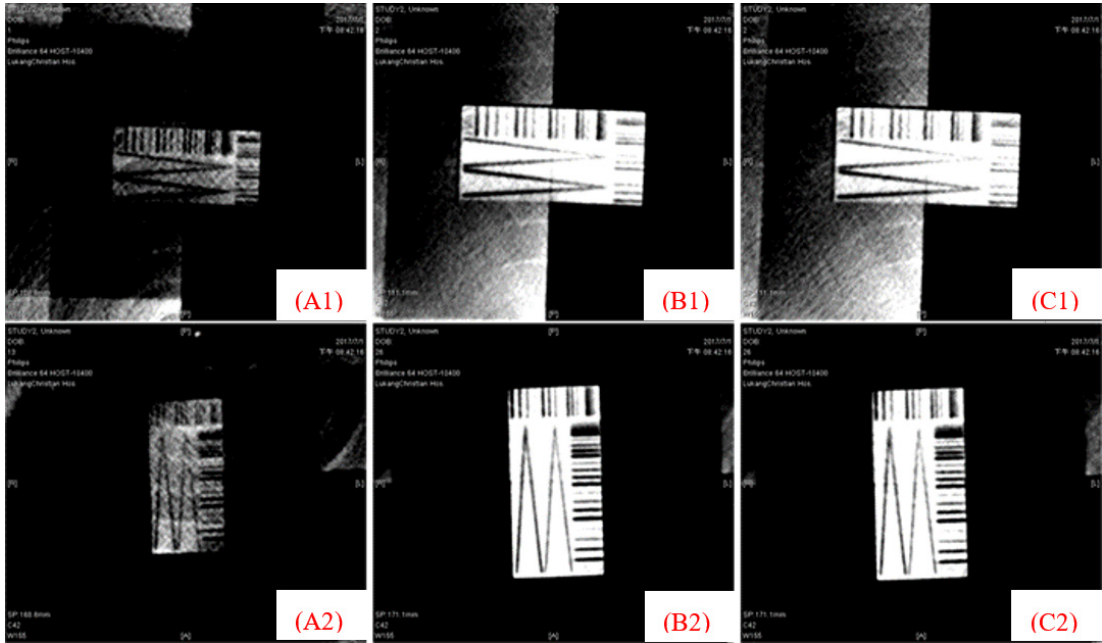
Figure 5. ( A1 ) Horizontal, ( A2 ) vertical of the routine examination, ( B1 ) horizontal, ( B2 ) vertical of the Taguchi experiment, and ( C1 ) horizontal, ( C2 ) vertical of the optimal experiment in 128 ‐ slice brain CT examinations.